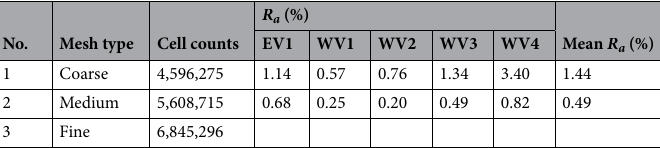
Table 2. Grid independence analysis.